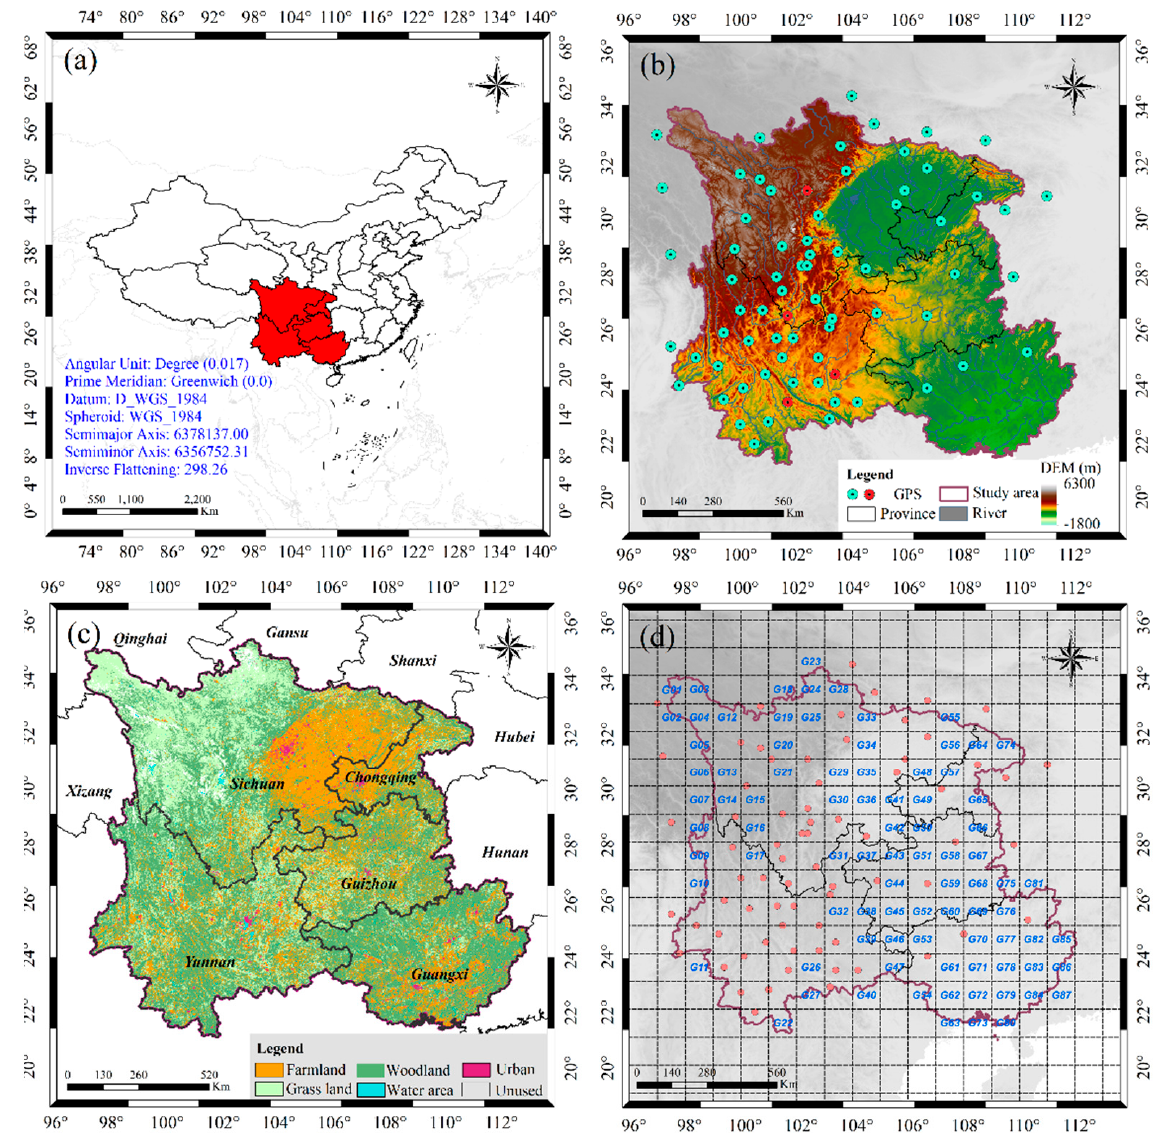
Figure 1. The information of GPS stations in southwest China. ( a ) The location of study region (red region) in China; ( b ) The distribution of the GPS stations (Green points); ( c ) The use of land over southwest China; ( d ) The relationship between the unobserved grids ( G1-G87 ) and the GPS stations (red points). Figure 2 indicates that the period of vertical deformation, temperature, and atmo- spheric pressure are close to one year. There is a negative correlation between the sequences of vertical deformation and atmospheric pressure. In addition, there is a certain phase difference between the sequence of atmospheric pressure and the sequence of vertical deformation. Overall, the periodicity of temperature and atmospheric pressure